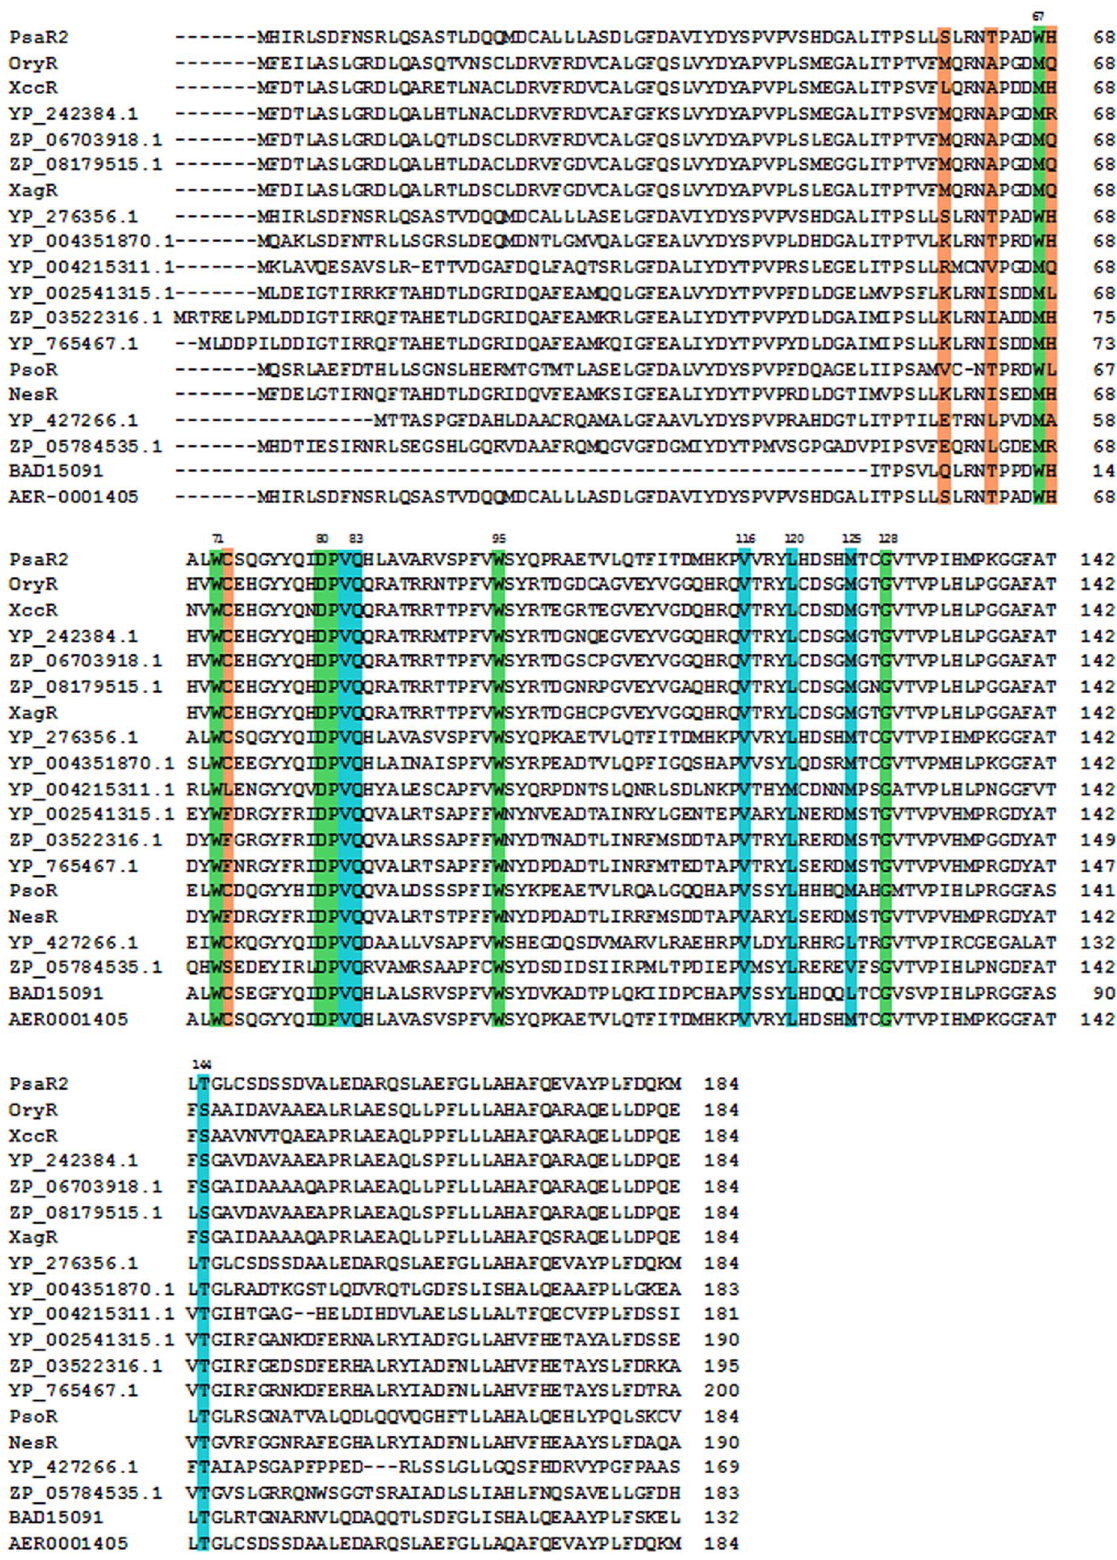
Figure 3. Multiple sequence alignment of the regulatory domain of PsaR2 with the PAB LuxR solos subfamily. The residues belonging to Cluster 1, Cluster 2 and Cluster 3 are highlighted in green, cyan and in orange, respectively.